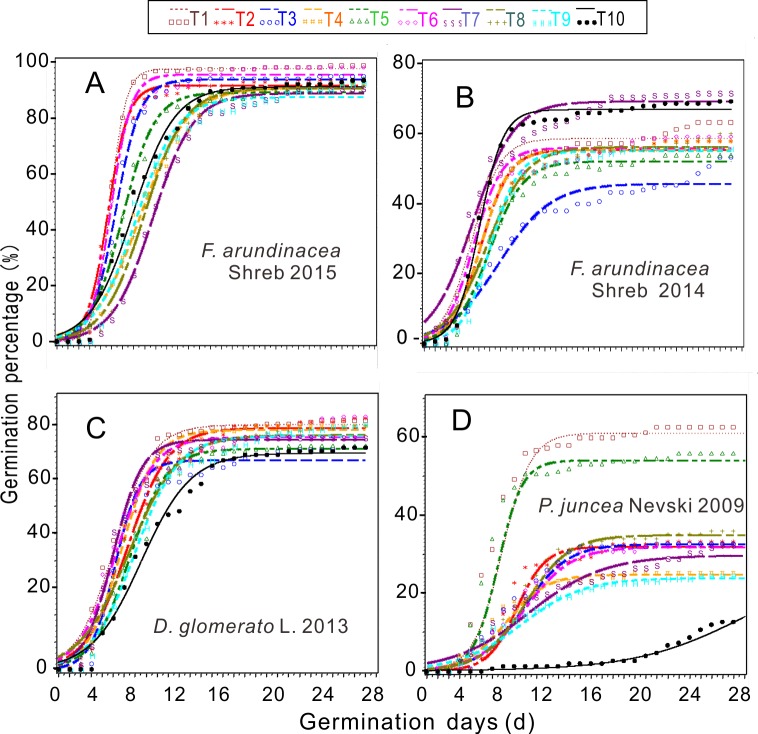
The curves of logistic models for germination percentage under the combined treatments for tall fescue 2015 (A), 2014 (B), orchardgrass 2013 (C) and Russian wild rye 2009 (D). From T1 to T9 are the treatments, and T10 is the control.